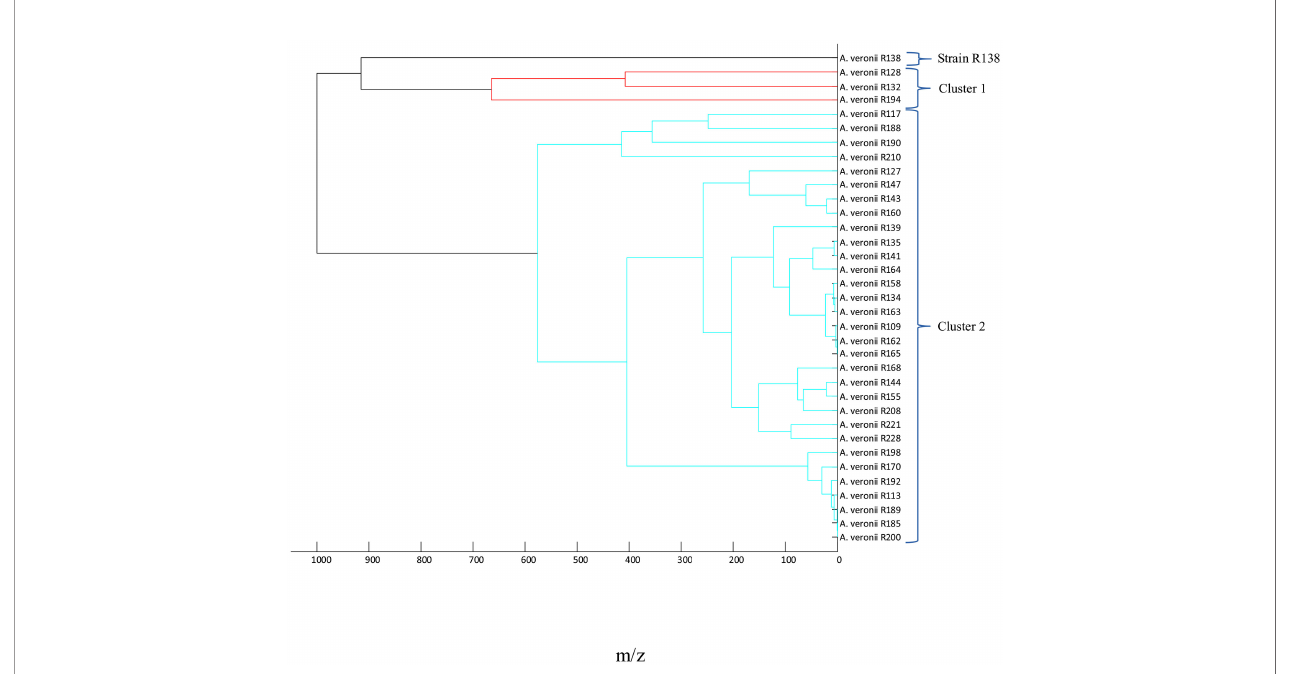
FIGURE 1 | Main spectra pro fi le dendrograms generated by MALDI Biotyper to determine the relationship between Aeromonas veronii ( n = 35)